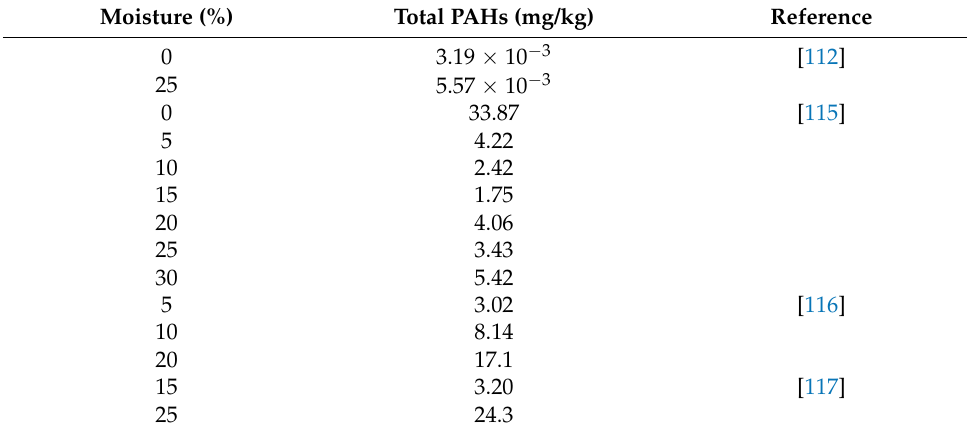
Table 10. The EF and composition of PAHs at different biomass moisture